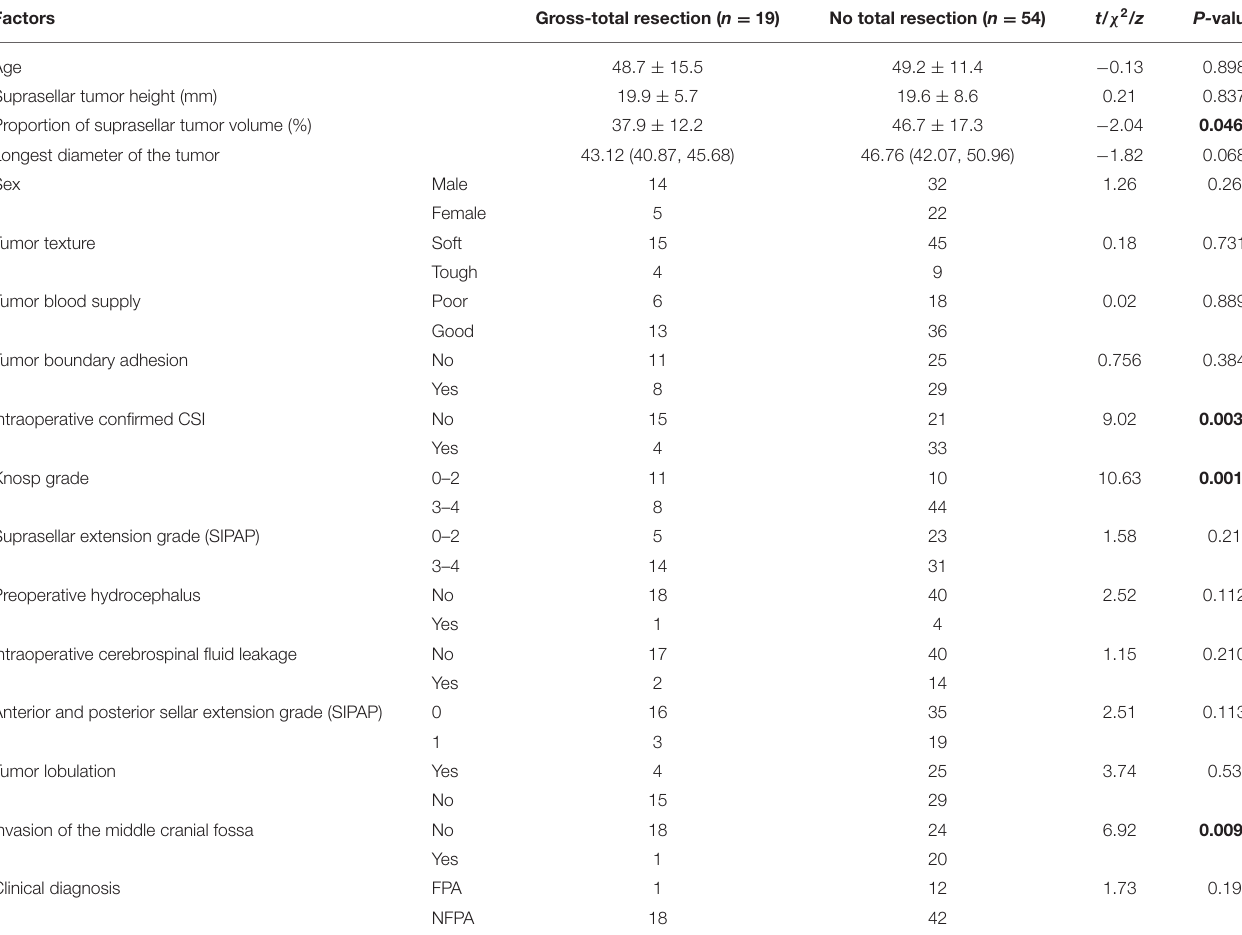
TABLE 2 | Univariate factor analysis of risk factors affecting the degree of GPA resection.